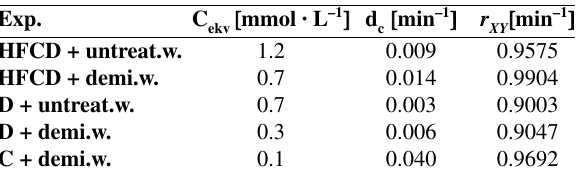
Table 4. Kinetic parameters and correlation